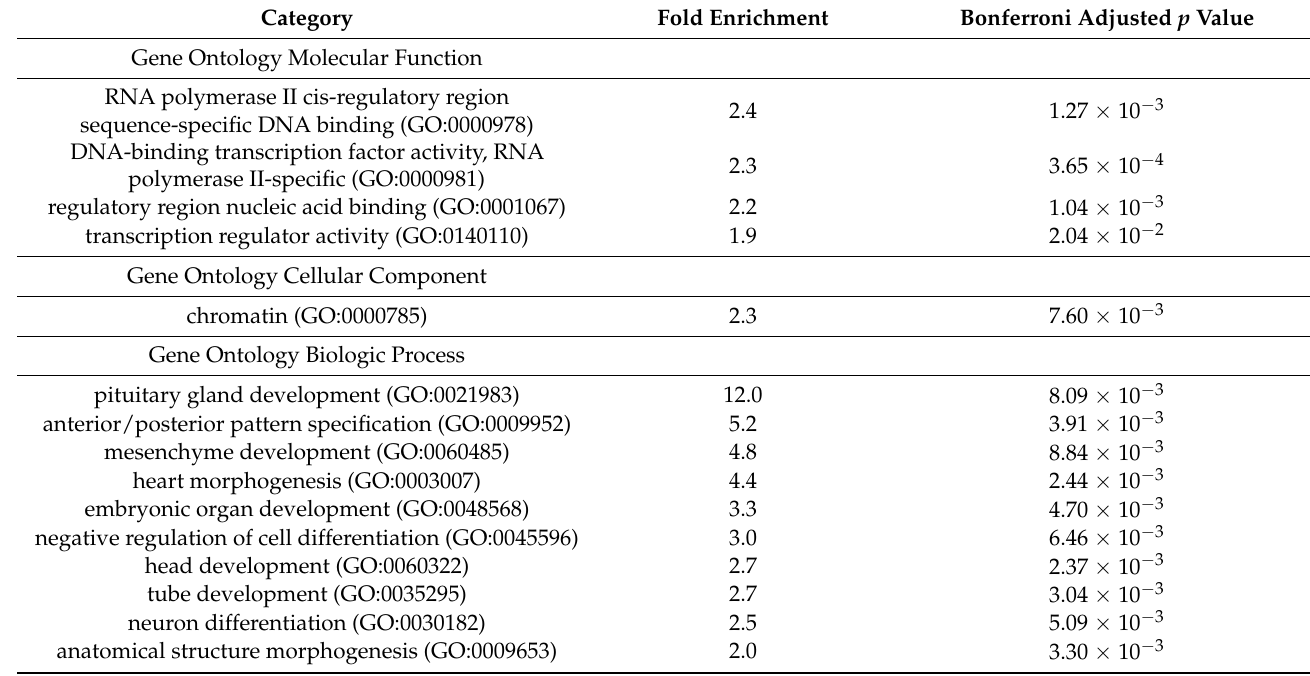
Table A5. Significantly Enriched Ontologies Based on Curve Severity DMR Promoter